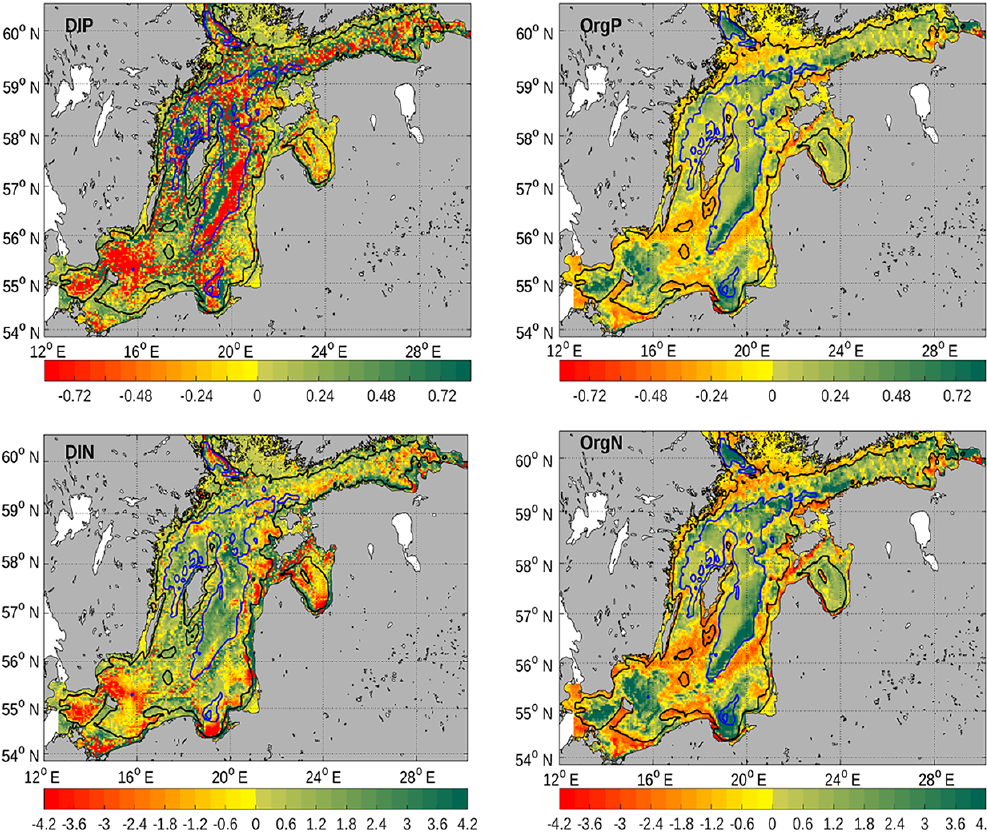
Figure 8. Spatial distributions of annual mean import of DIP, OrgP, DIN and OrgN averaged for the period 1970–1999. The magnitude of import and its corresponding value (ktkm − 2 yr − 1 ) are shown by the background color and color bar, respectively. Green colors denote positive values (import), and yellow to red colors denote negative values (export). The black and blue lines show 30 and 100m depth contours of the model,